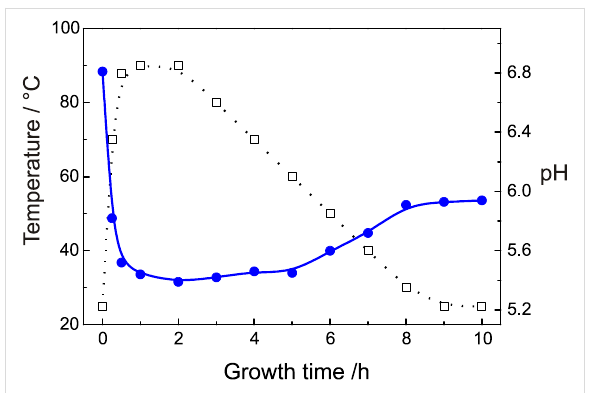
Figure 4: Growth temperature and measured pH value as a function of growth time for the formation of ZnO nanotubes (solid line: pH value; dotted line: growth